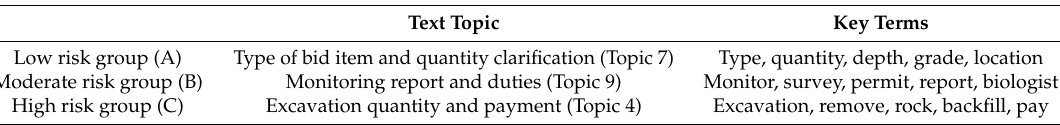
Table 5. Text topic according to each risk